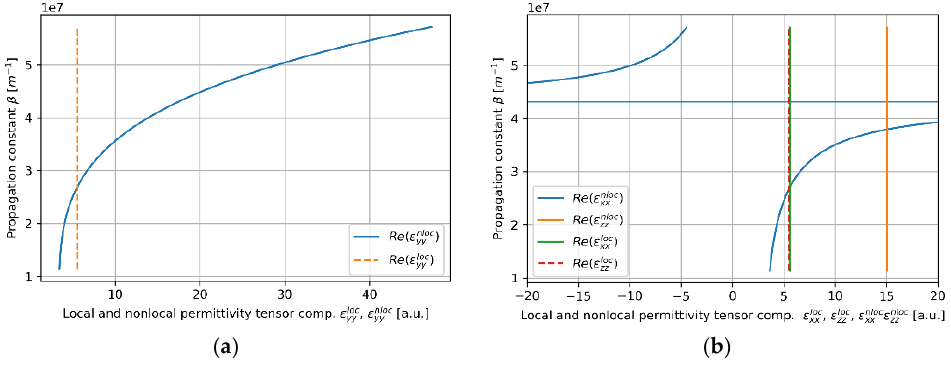
Figure 8. Real parts of components of effective local and nonlocal tensors (horizontal axis) of the core layer with dielectric layer thickness t Nb2O5 = 80 nm plotted versus propagation constant (vertical axis), which are encountered by TE ( a ) and TM waveguide modes ( b ).